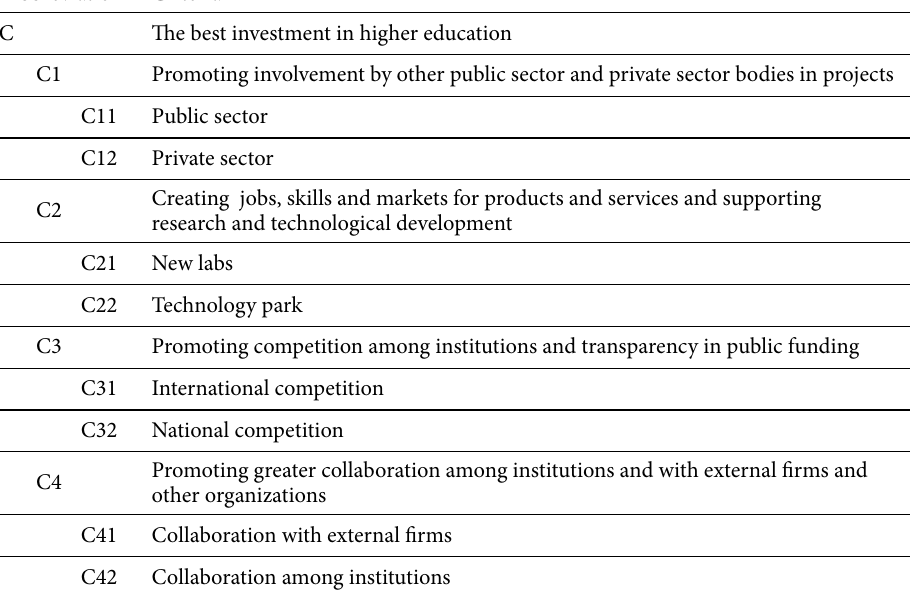
Table 1. The evaluation